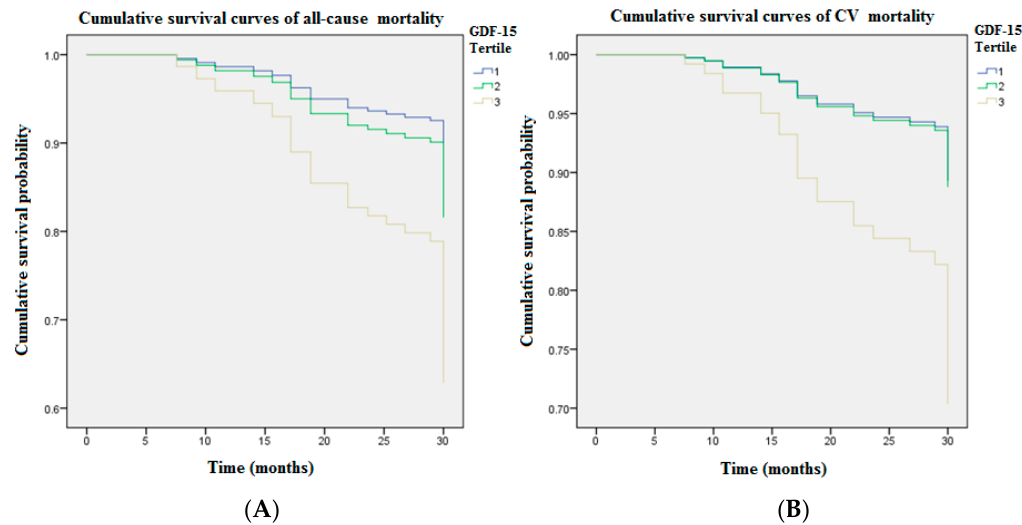
Figure 1. The cumulative survival curves of mortality risks showed GDF15 tertiles remained significant after adjusting for age and albumin during 4650.9 person-months follow-up (Tertile 1 GDF15 < 1314.8 pg/mL; Tertile 2 GDF15 = 1314.8–1707.1 pg/mL; Tertile 3 GDF15 > 1707.1 pg/mL). ( A ) The highest tertile of GDF15 (>1707.1 pg/mL) was associated with an incremental risk of all-cause mortality (aHR: 3.06 [95% CI: 1.20–7.82], p < 0.05). ( B ) The association between the highest tertile of GDF15 and CV mortality remained robust after multivariable adjustment (aHR: 3.11 [95% CI: 1.02–9.50], p < 0.05). GDF15 = growth differentiation factor-15.